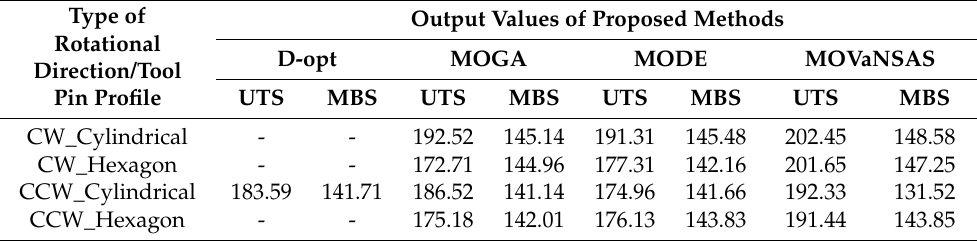
Table 11. The computational results of UTS and MBS of each heuristic.